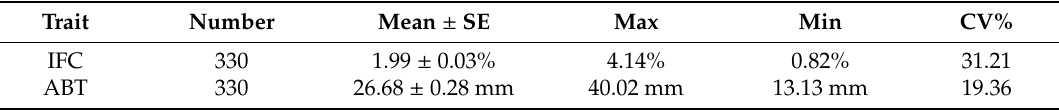
Figure 2. Statistical analysis of IFC and ABT of Suhuai pigs. IFC = intramuscular fat content (green box); ABT = average backfat thickness (blue box); statistical analysis was performed using GraphPad Prism 6 with the quartile method. Table 1. Descriptive statistics of the intramuscular fat content (IFC) and average backfat thickness (ABT) in 330 Suhuai